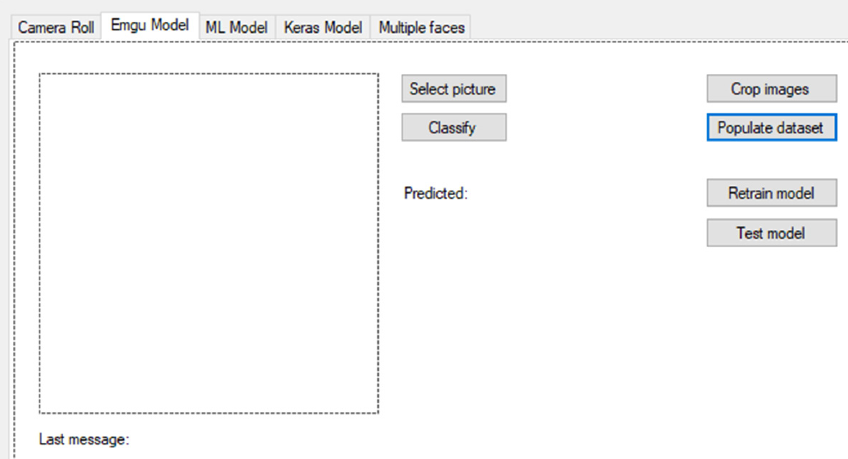
Figure 5. Example of the Emgu Model user interface (own creation).